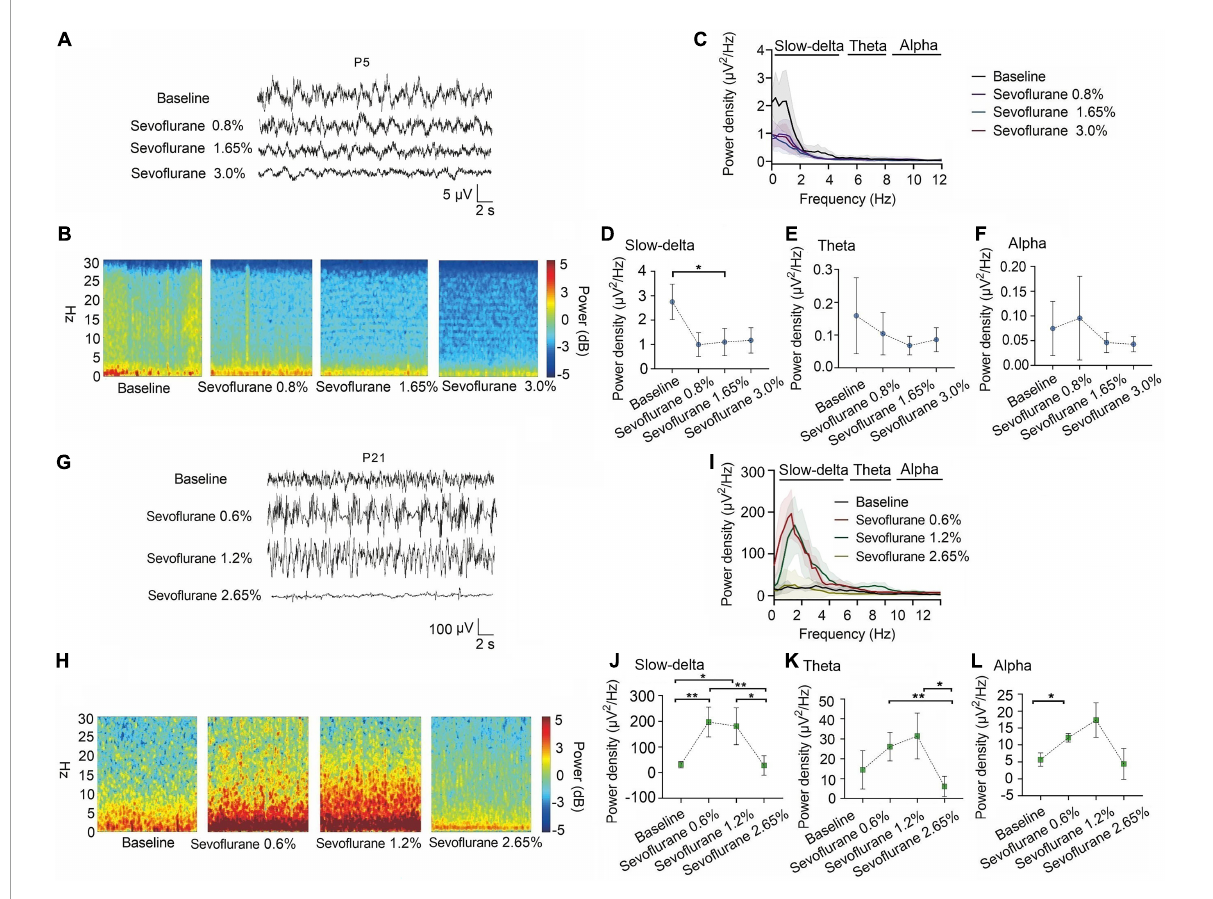
FIGURE4 Slow-delta oscillations was suppressed in P5 rats with increasing sevoflurane concentrations, while enhanced slow-delta, theta and alpha oscillations in P21 rats. (A,B) EEG and it’s power spectrogram of P5 rats under 50%MAC LORR , MAC LORR and MAC immobility of sevoflurane. (G,H) EEG and it’s power spectrogram of P21 rats under 50%MAC LORR , MAC LORR and MAC immobility of sevoflurane. (C,I) EEG power spectral density of P5, P21 rats under increased concentrations of sevoflurane concentrations ( n = 5). (D–F) The change of power density of slow-delta, theta and alpha oscillations on P5 rats. (J–L) The change of power density of slow-delta, theta and alpha oscillations on P21 rats. Data are presented as mean ± SD. * P < 0.05, ** P < 0.01 by repeated measures one-way ANOVA (D–F, J–L) .